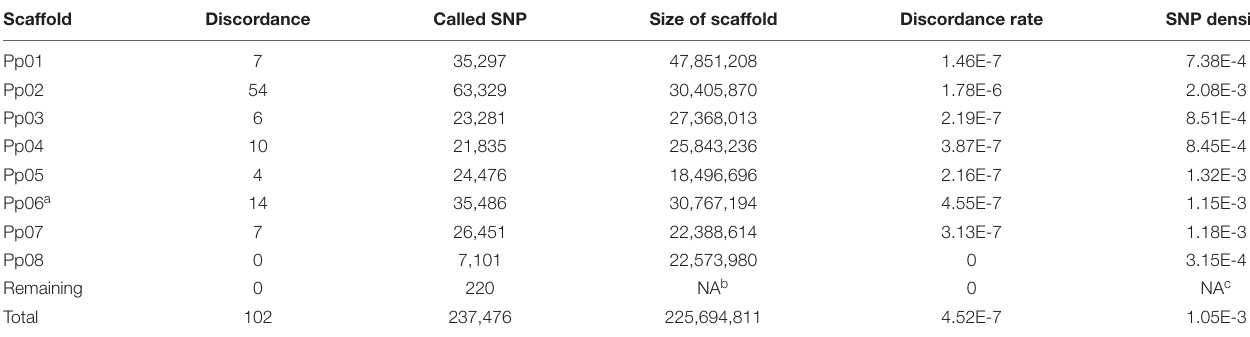
TABLE 2 | Genotype discordance between wild-type and bud sport genomes.